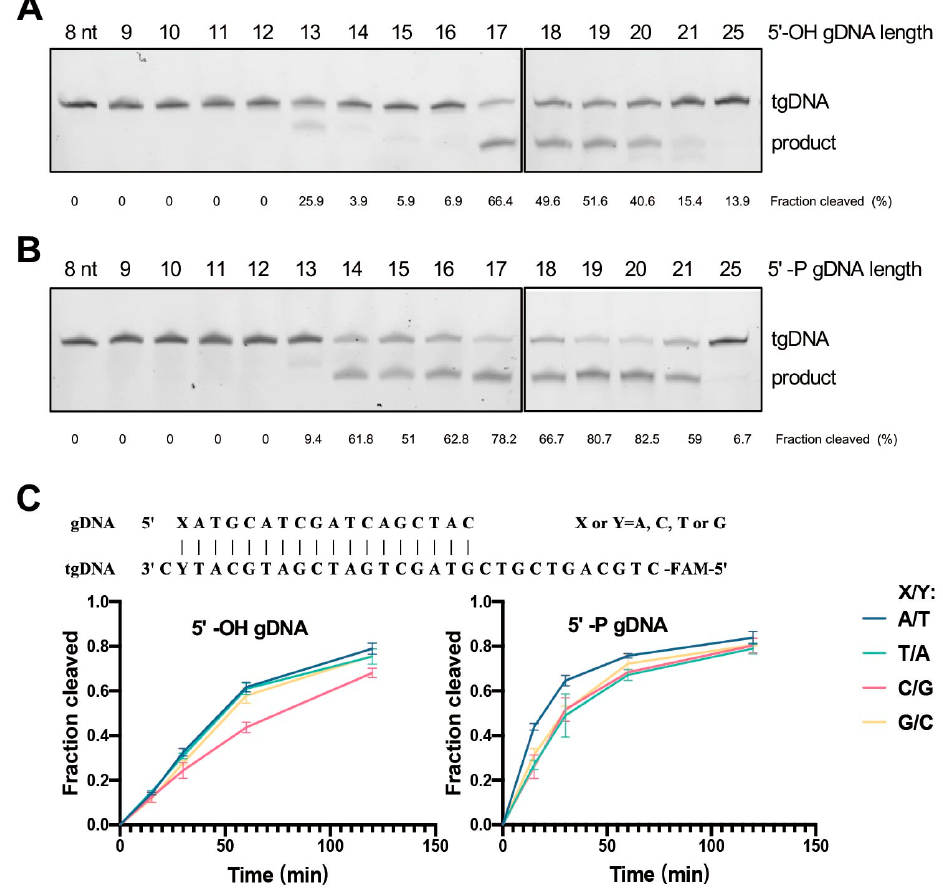
Figure 3. Effects of guide length and guide 5 ′ -terminus on CdAgo activity. ( A ) PAGE analysis of cleavage with the 5 ′ -OH guides in various lengths. ( B ) PAGE analysis of cleavage with the 5 ′ -P guides in various lengths. ( C ) Kinetic analysis of the CdAgo activities with the 5 ′ -OH or 5 ′ -P guides containing four different 5 ′ -terminal nucleotides (see also Figure S3). Means and standard deviations from three independent experiments are shown.